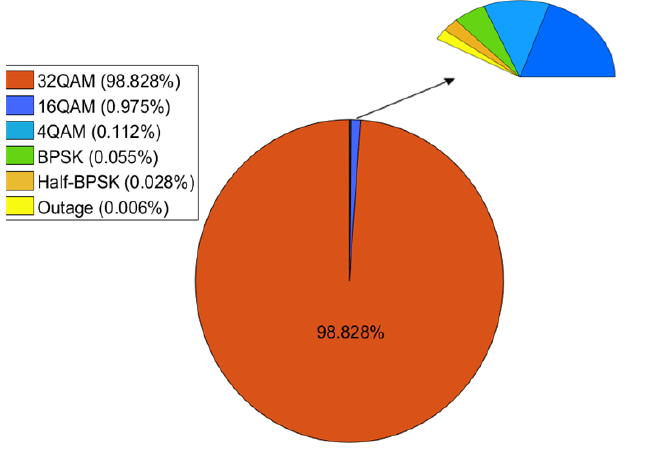
Figure 6. Adaptive modulation modes for full-duplex wireless back-haul E-band link along 300